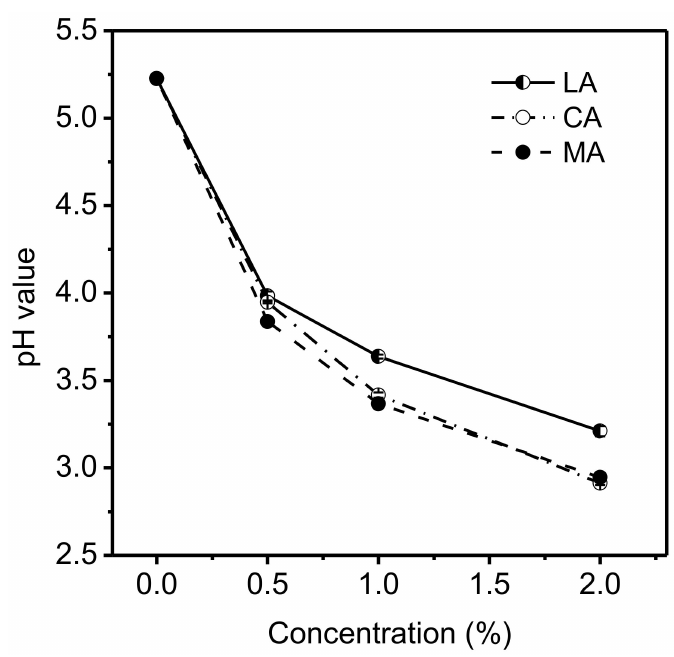
Figure 1. Effects of various concentrations of acids on the pH value of 6.67% gelatin solutions. Table 1. Chemical properties of lactic acid, malic acid, and citric acid.